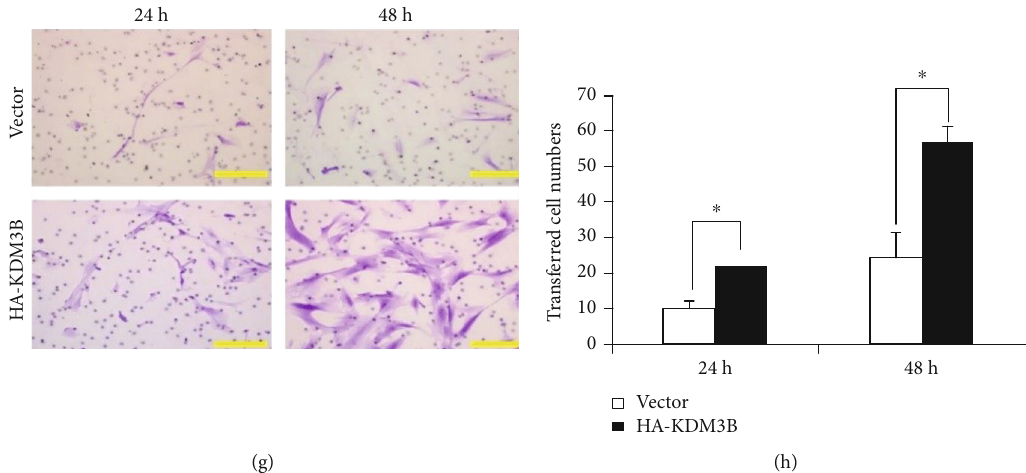
Figure 3: KDM3B enhanced the migration and chemotaxis potential of SCAPs. The (a) scratch migration assay and (b) quantitative analysis results demonstrated that KDM3B knockdown led to a signi fi cant decrease in the migration ability of SCAPs at 24 h and 48h. The (c) transwell chemotaxis assay and (d) quantitative analysis results showed that KDM3B knockdown led to a decrease in the chemotaxis ability of SCAPs at 24h and 48h. The (e) scratch migration assay and (f) quantitative analysis results demonstrated that KDM3B overexpression led to a signi fi cant increase in the migration ability of SCAPs at 24 h and 48h. The (g) transwell chemotaxis assay and (h) quantitative analysis results showed that KDM3B overexpression led to an increase in the chemotaxis ability of SCAPs at 24h and 48 h. Statistical signi fi cance was determined using Student ’ s t -test. All error bars represent SD ( n = 3 or 6). P < 0 : 05 . ∗∗ P ≤ 0 : 01